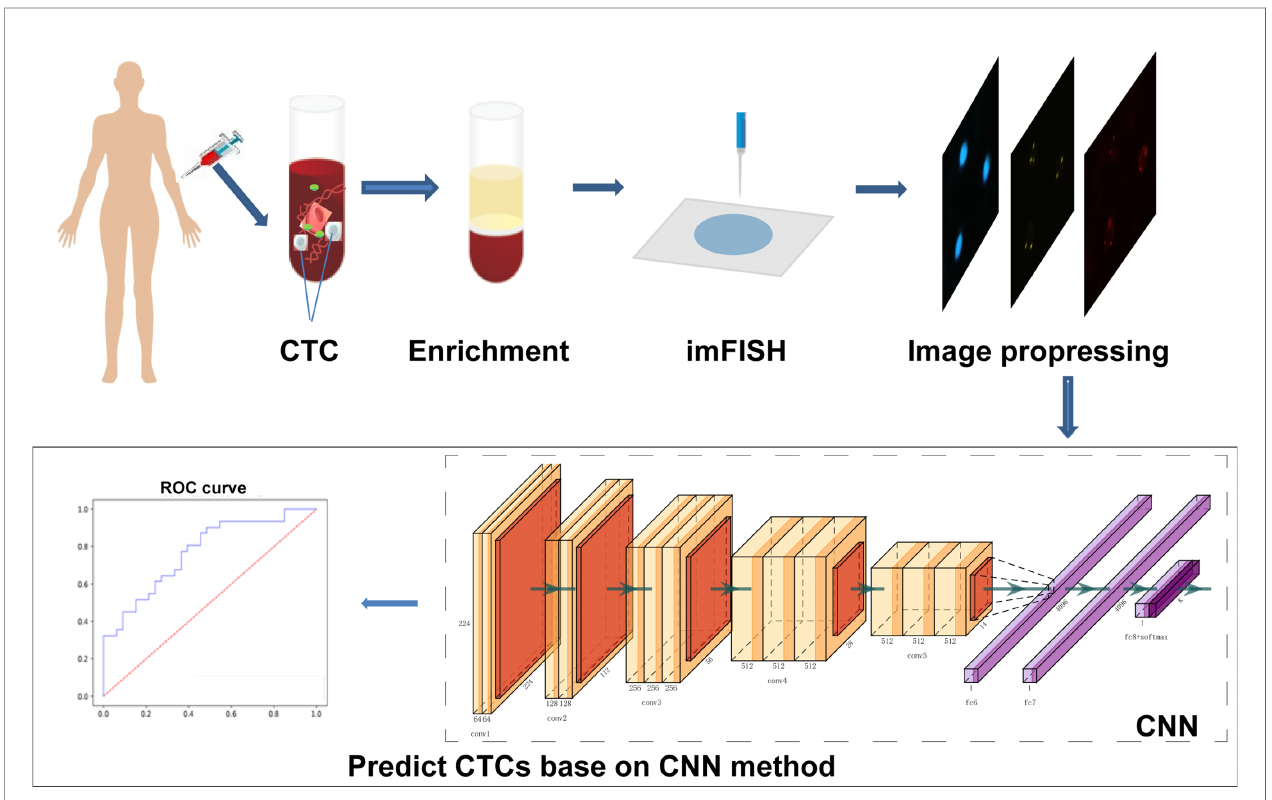
FIGURE 1 | The protocol of whole